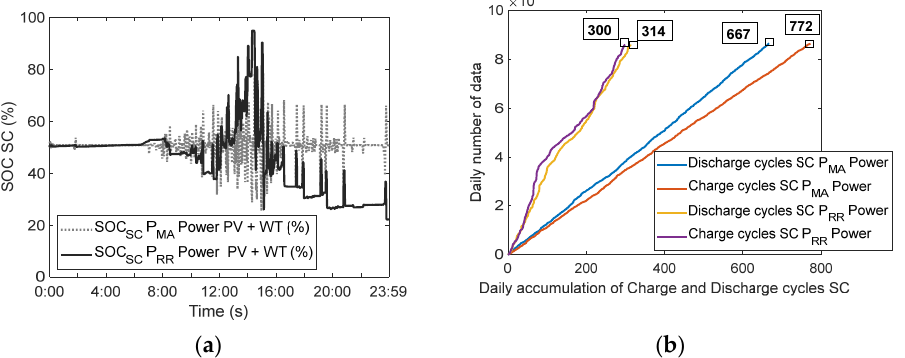
Figure 11. SC operability in Configuration 2, time step one second: ( a ) state of charge; ( b ) cumulative charging/discharging cycles.